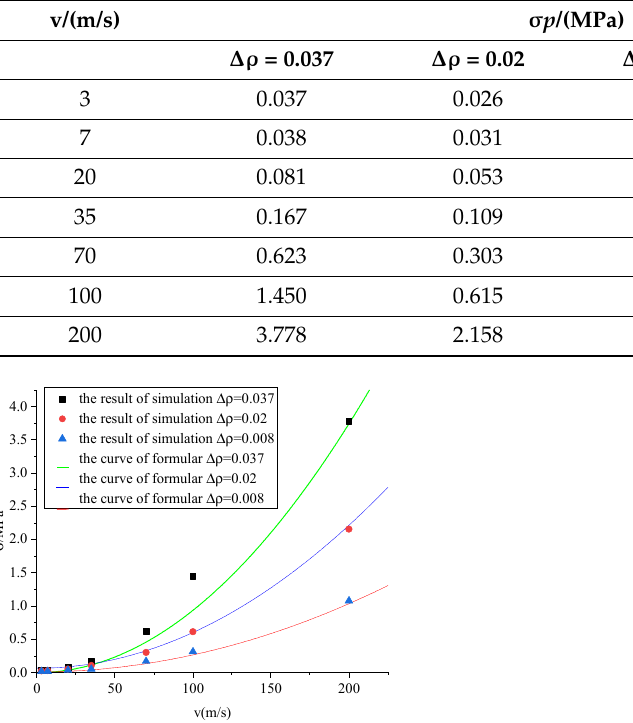
Table 2. Platform stress in different condition.